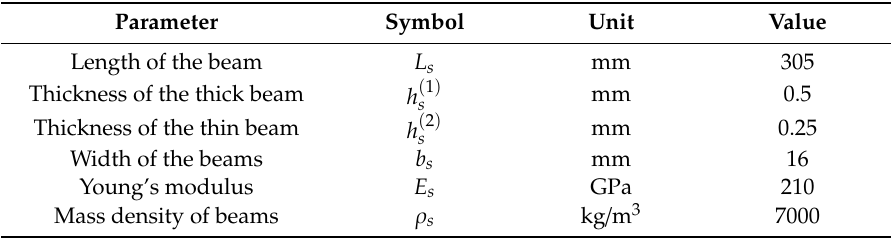
Table 1. Physical and geometrical parameter values of the system.